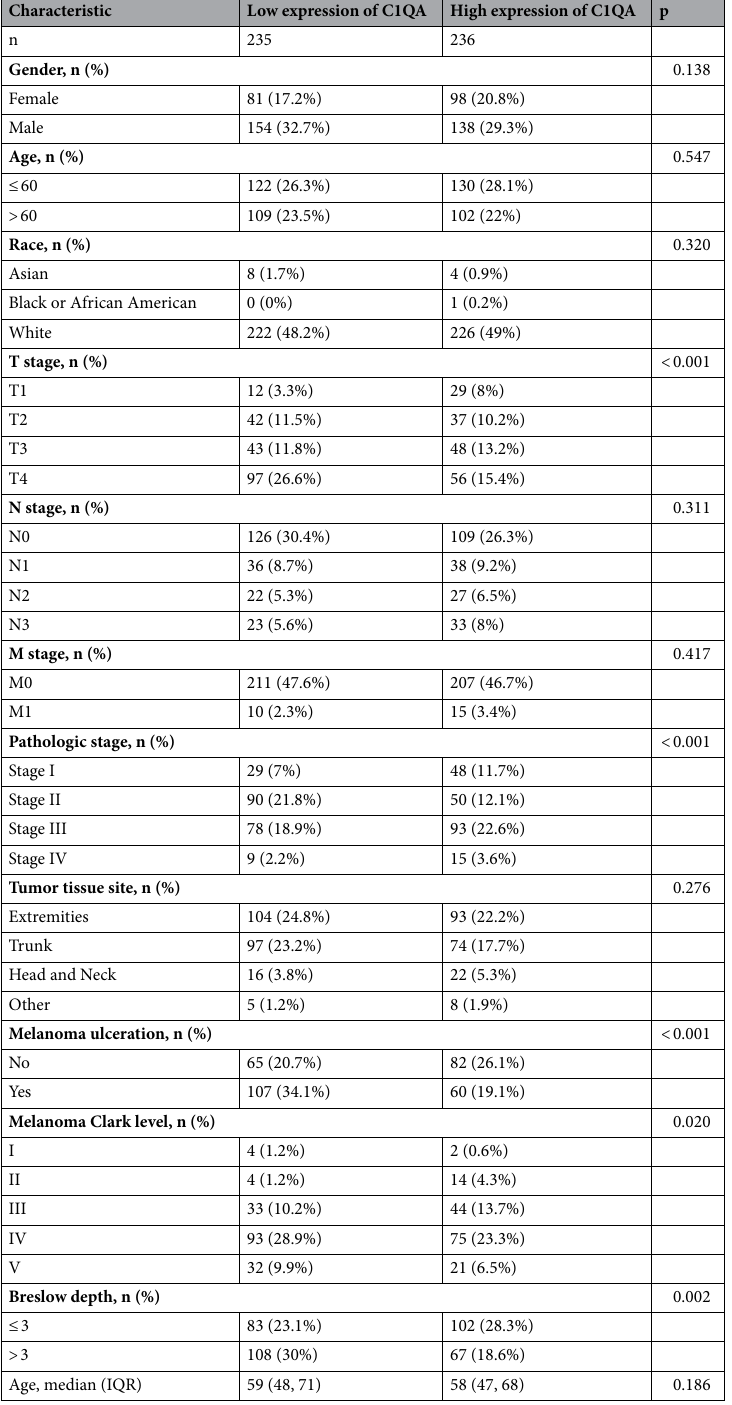
Table 2. C1QA expressions in clinical